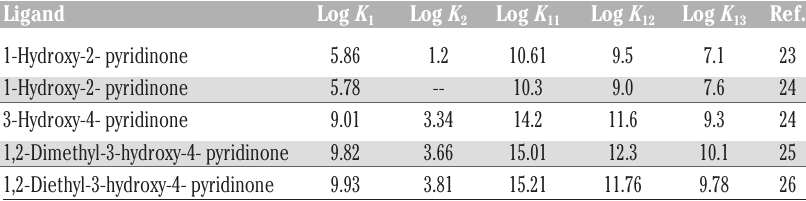
Table 1. Protonation constants (log K , log K ) and iron complex formation constants 1 2 (log K , log K and log K ) for some 11 12 13